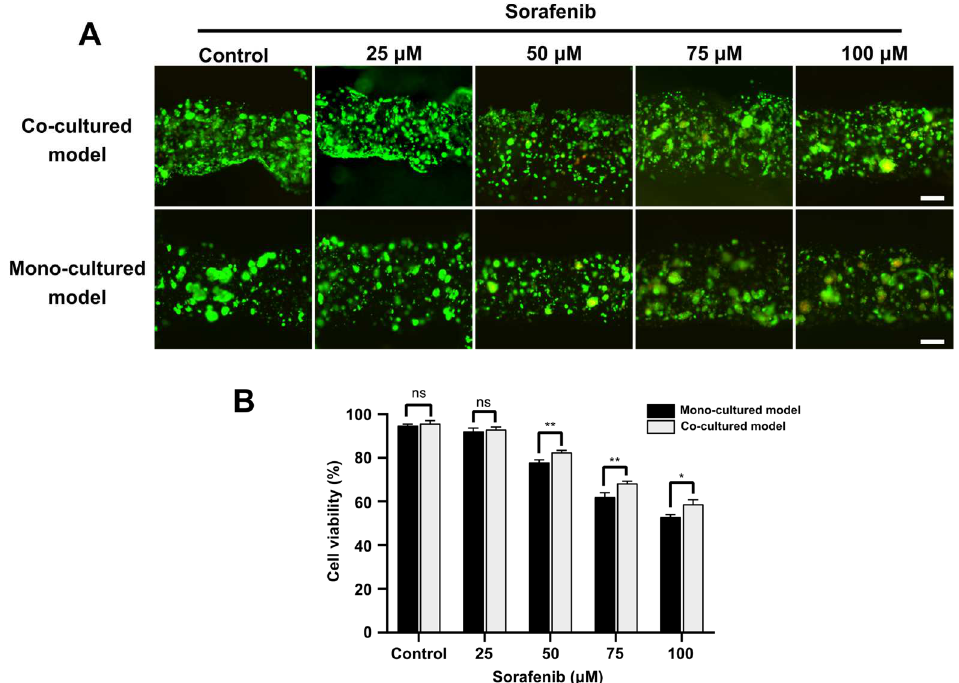
Figure 5. Drug evaluation on co-cultured liver cancer models and mono-cultured liver models. ( A ) Live/dead images showing different 3D liver cancer models after incubation with different concentrations of Sorafenib. Scale bar: 200 µm. ( B ) Statistical analysis of cell viabilities in both constructs at different drug concentrations. * p < 0.05 and ** p < 0.01.